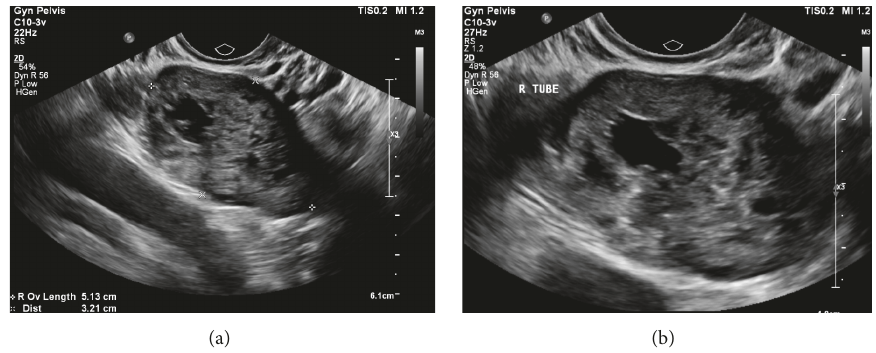
Figure 1: Ultrasound images showing normal right ovary and right tubal ectopic.